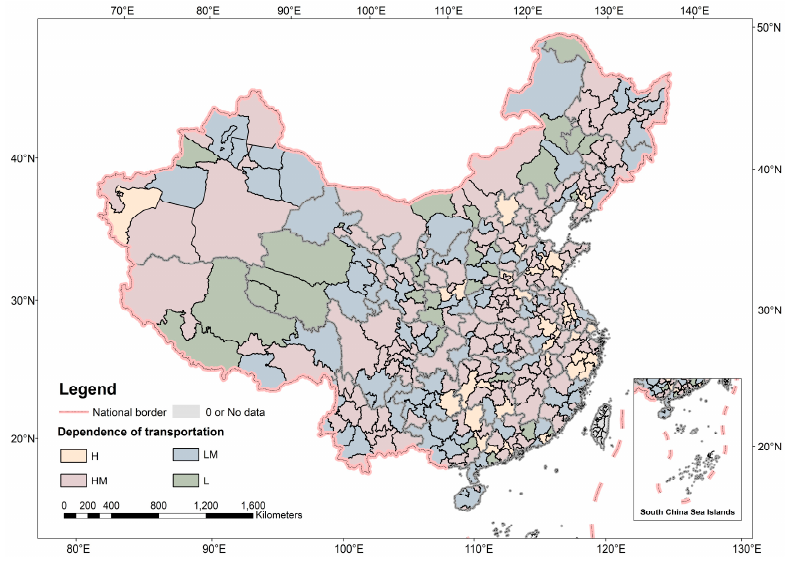
Figure 4. Transportation dependence of prefecture ‐ level cities.